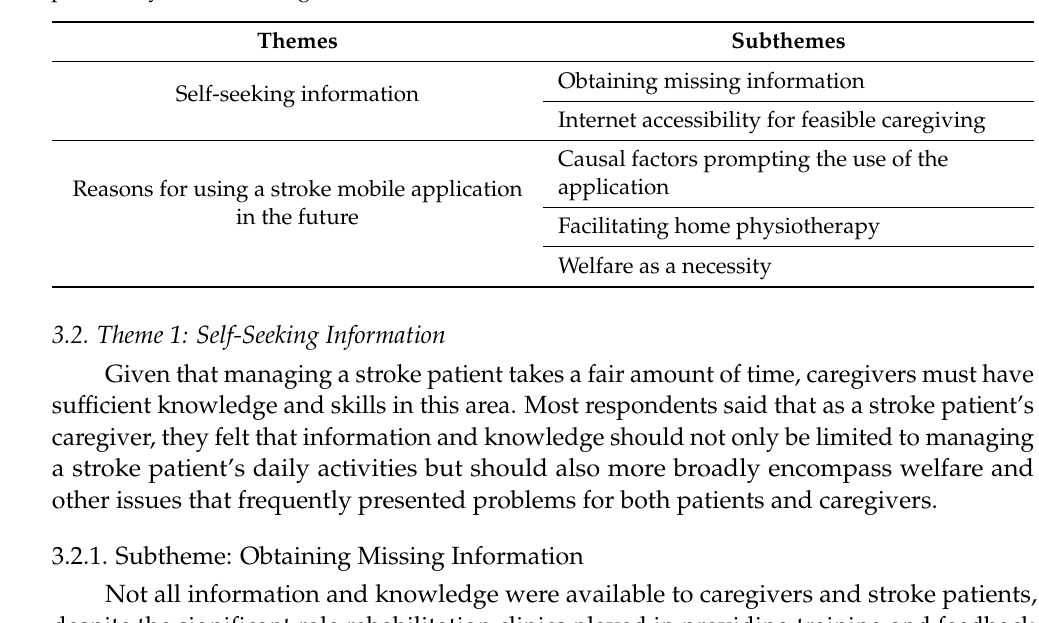
Table 2. Themes and subthemes regarding the need for a mobile application for managing stroke patients by informal